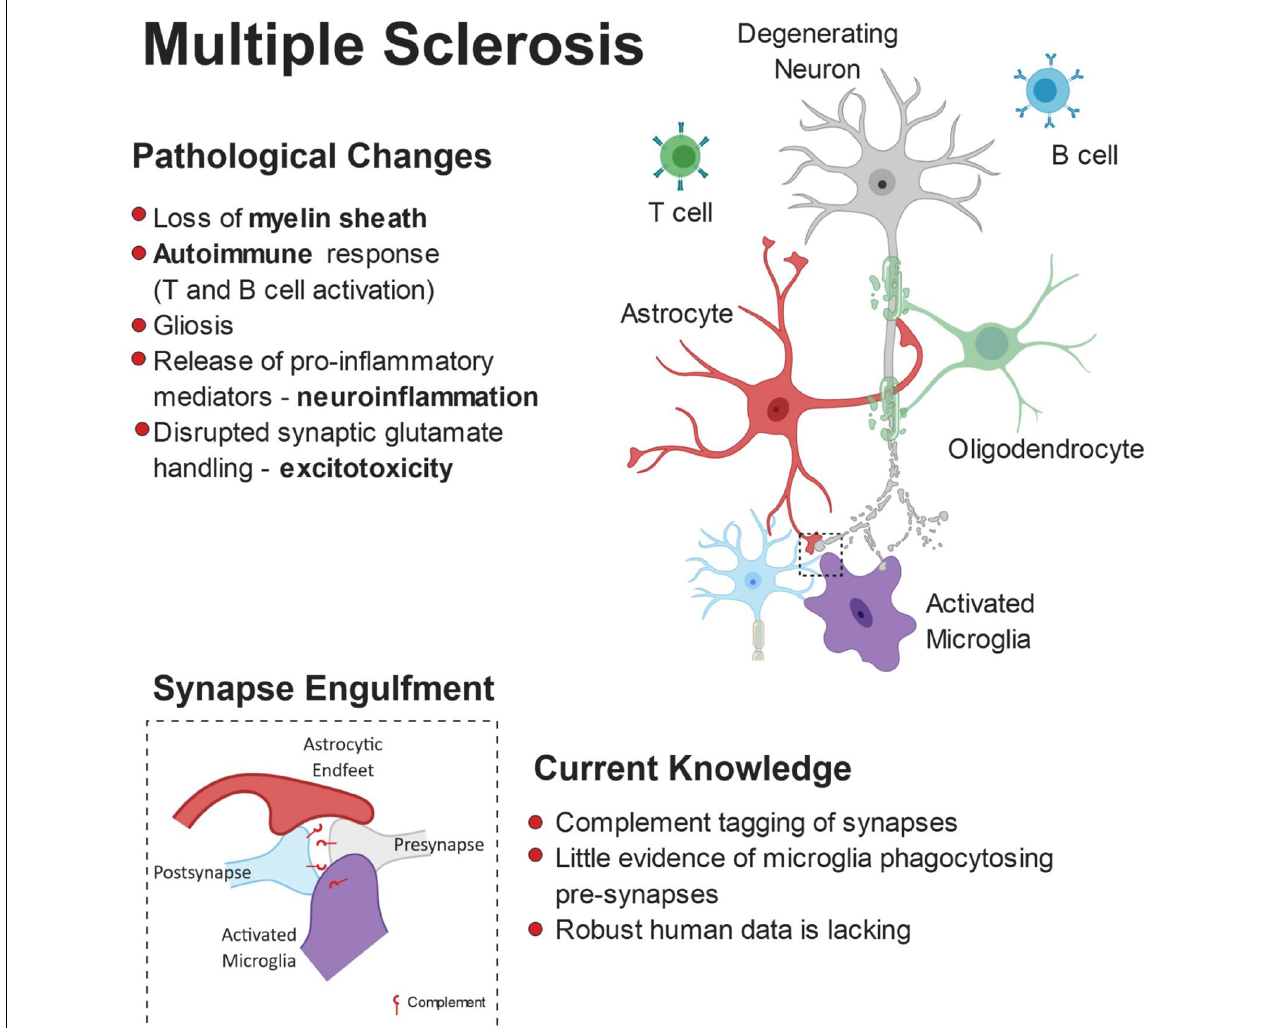
FIGURE 5 | Pathophysiology of multiple sclerosis (MS). While myelin loss is a central feature of MS pathology, it is accompanied by neurodegeneration, gliosis and immune cell (B-cells and T-cells) infiltration. Release of pro-inflammatory mediators and disrupted glutamate handling by glial cells leads to a toxic neuronal milieu. Furthermore, there is evidence that microglia are involved in complement-dependent synapse